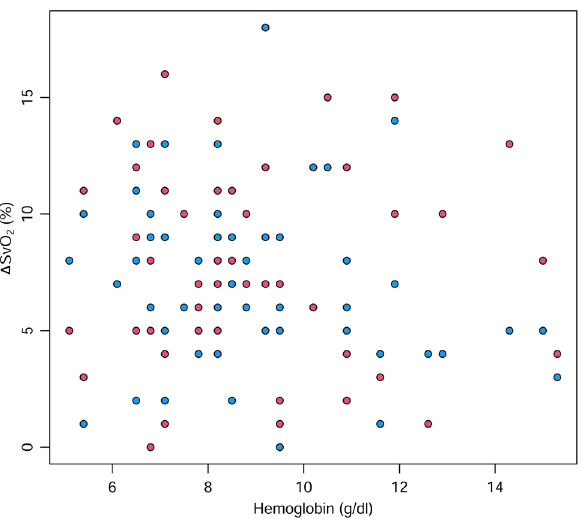
Figure 4. The relationship between ΔSvO 2 and hemoglobin concentration. ΔSvO 2 , change of mixed venous oxygen saturation. Red dots, T0–T1; blue dots, T1–T2. Created with R: A language and environment for